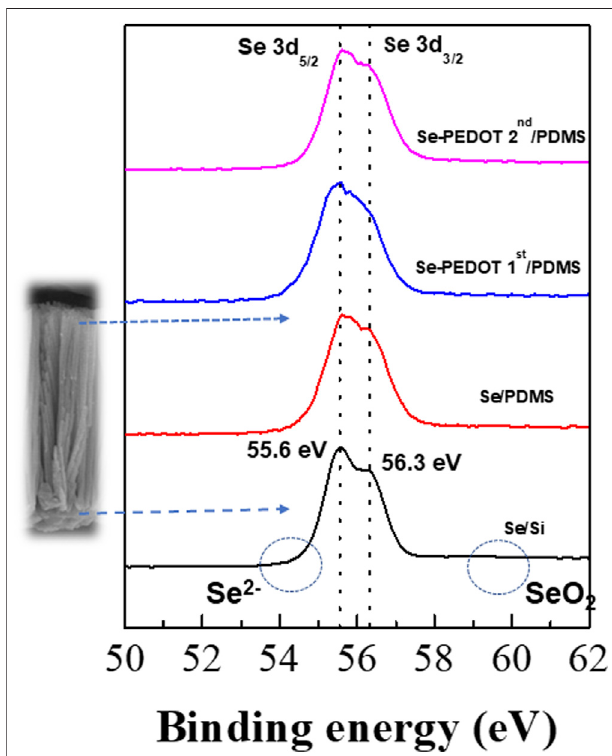
FIGURE 6 | X-ray photoelectron spectra of Se 3d 5/2 BE and Se 3d 3/2 of the Se wire:PEDOT:PSS composite.